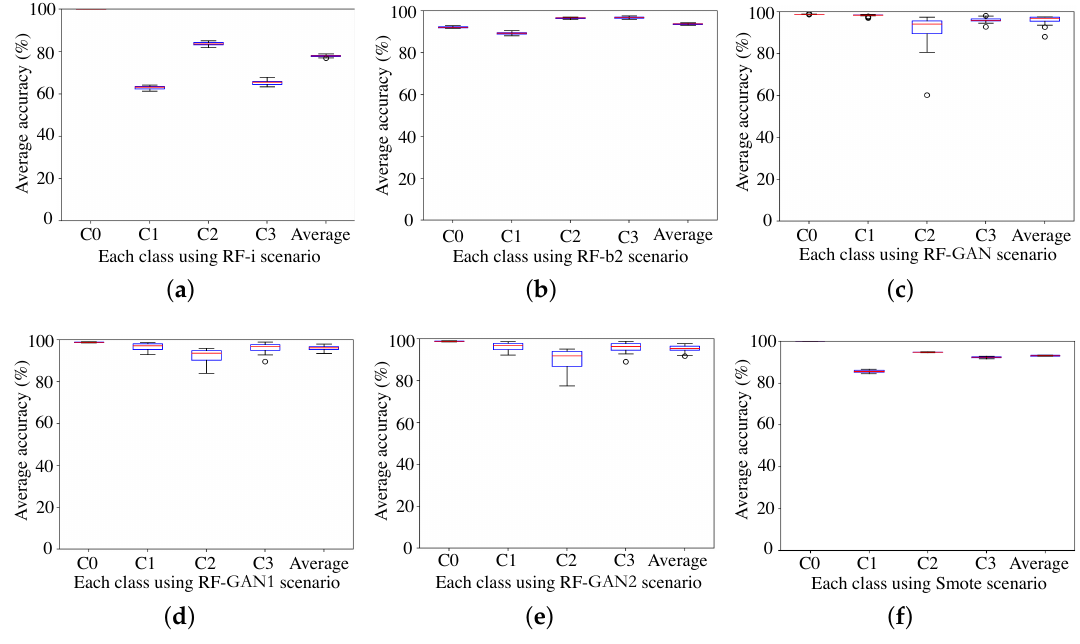
Figure 11. Recall indicators for the different scenarios: ( a ) RF-i; and ( b ) RF-b2; ( c ) RF-GAN; ( d ) RF-GAN1; ( e ) RF-GAN2; and ( f )